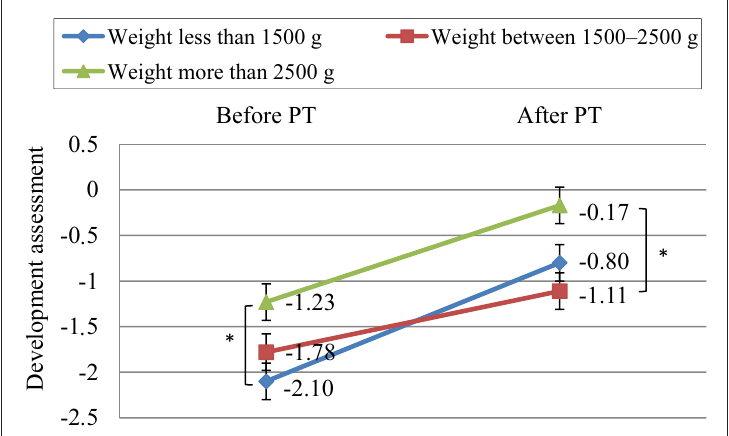
Figure 2. Sitting development eva-luation in different birth weight infant